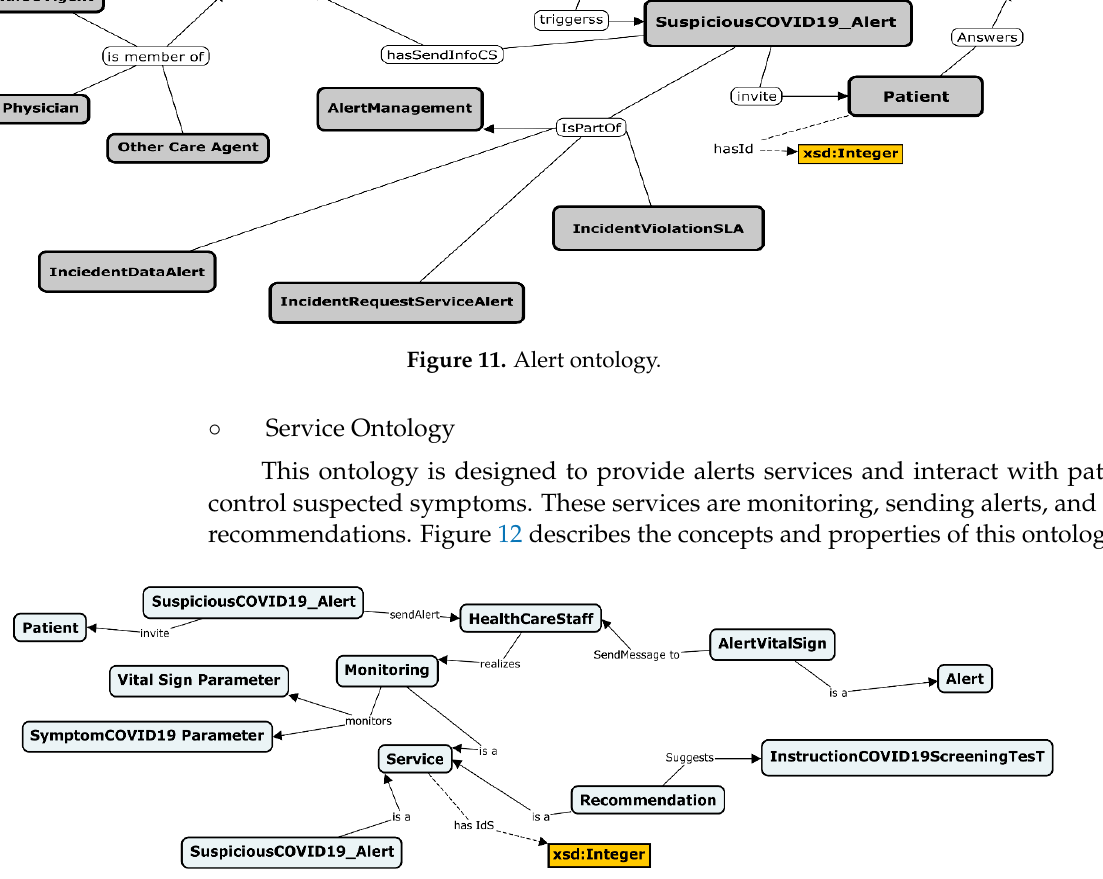
Figure 12. Service ontology.